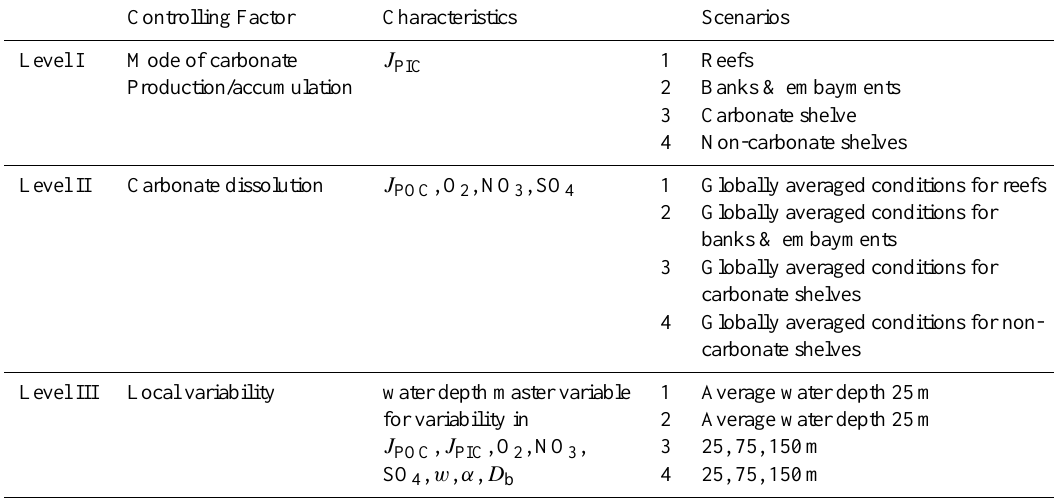
Table 2. Hierarchical classification scheme (see text for